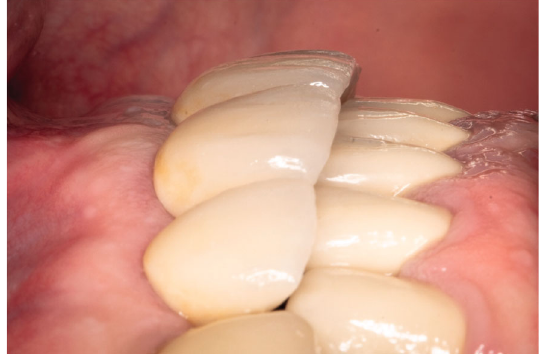
Figure 12: Clinical lateral vision. A good maintenance of the buccal thickness is seen.